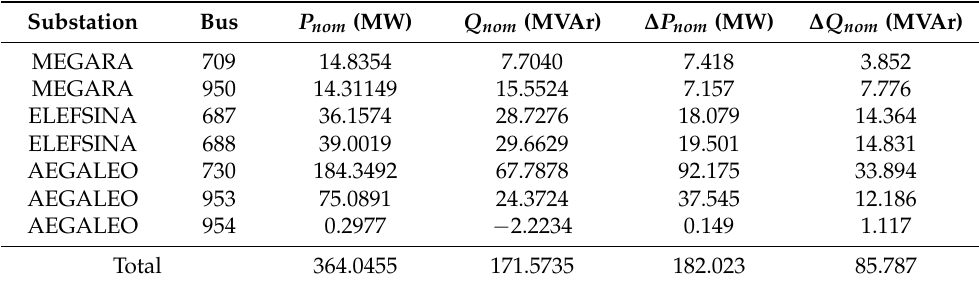
Table 4. Nominal load and available (50%) load shedding from substations in the area of Athens in 2004.